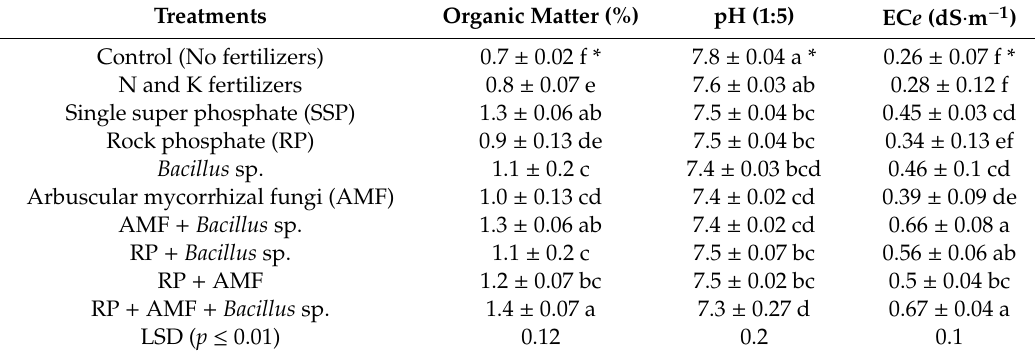
Table 4. Maize post-harvest soil organic matter content, pH, and EC e as influenced by AMF and PSB inoculation with